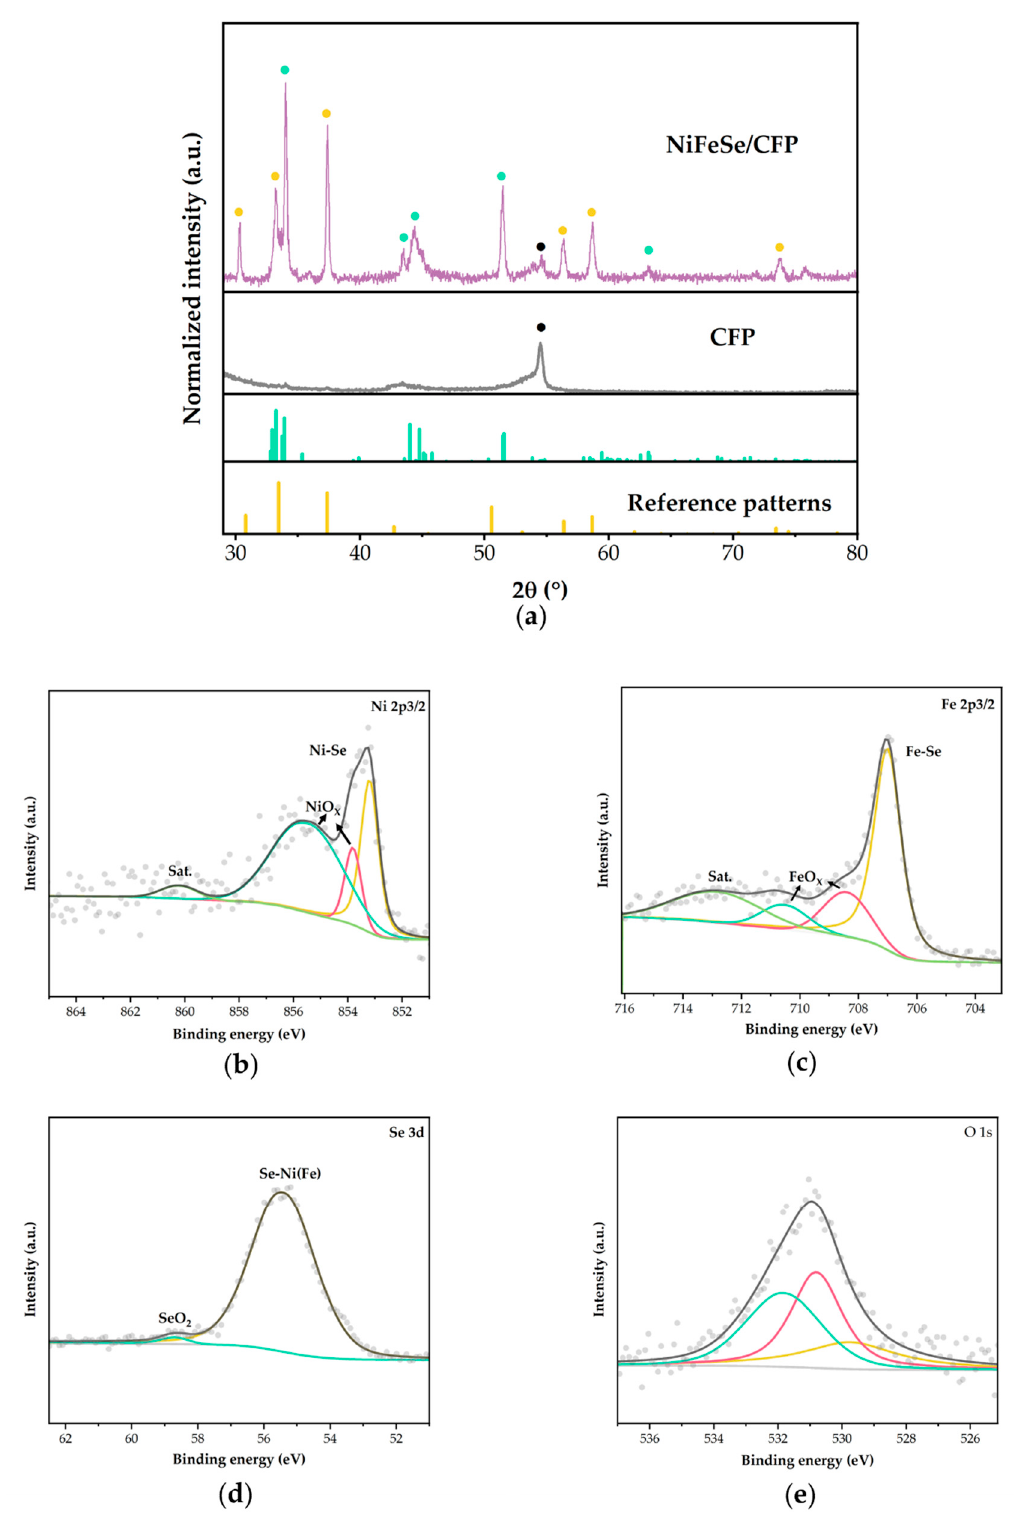
Figure 3. X-ray characterizations: ( a ) XRD spectra of NiFeSe/CFP and the reference patterns of NiSe 2 (yellow, ICDD: 04-003-1991), Fe 2 NiSe 4 (cyan, ICDD: 01-089-1968). The peaks marked with black dots correspond to CFP substrate. XPS spectra of ( b ) Ni 2p, ( c ) Fe 2p, ( d ) Se 3d and ( e ) O 1s in NiFeSe/CFP.